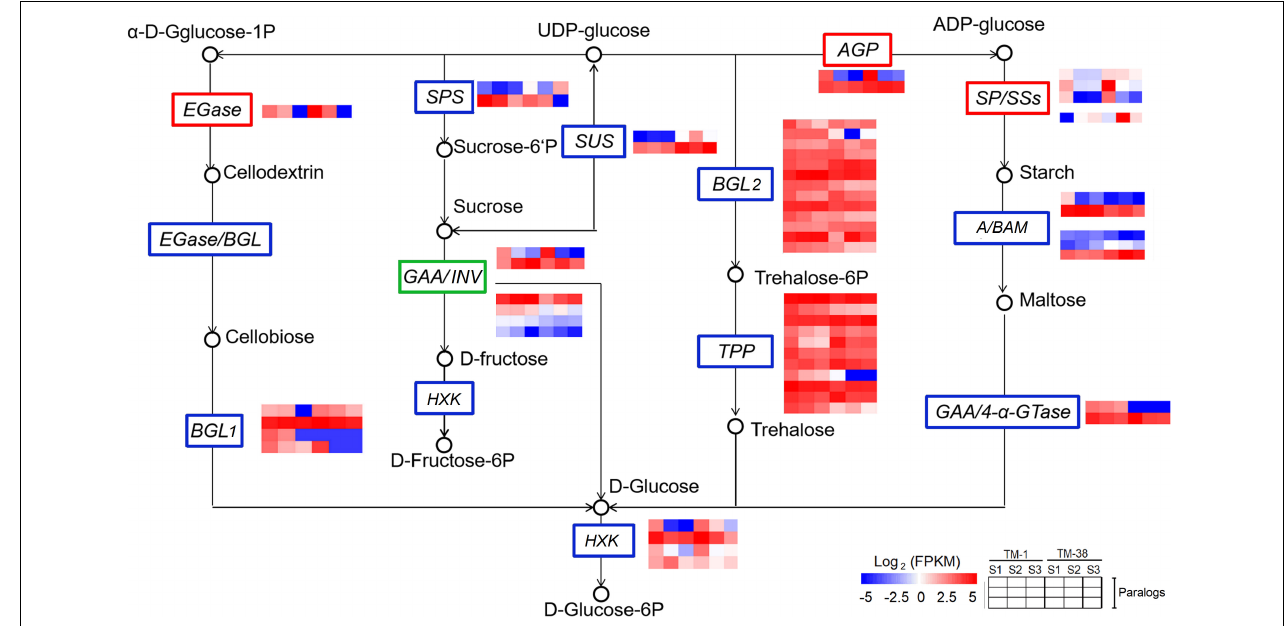
FIGURE 6 | Differential expression of genes involved in starch and sucrose metabolism pathway in TM-1 and TM-38 at three developmental stages. Heat maps depict the normalized gene expression values, which represent the means ± SD of three biological replicates. Expression values of 18 libraries are presented as FPKM normalized log 2 -transformed counts.